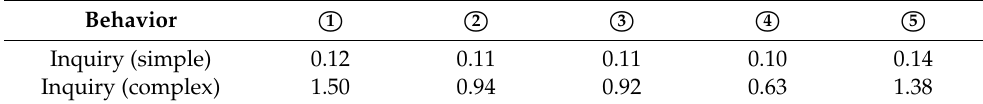
Table 10. Response Time for each CyCOP Visualization.